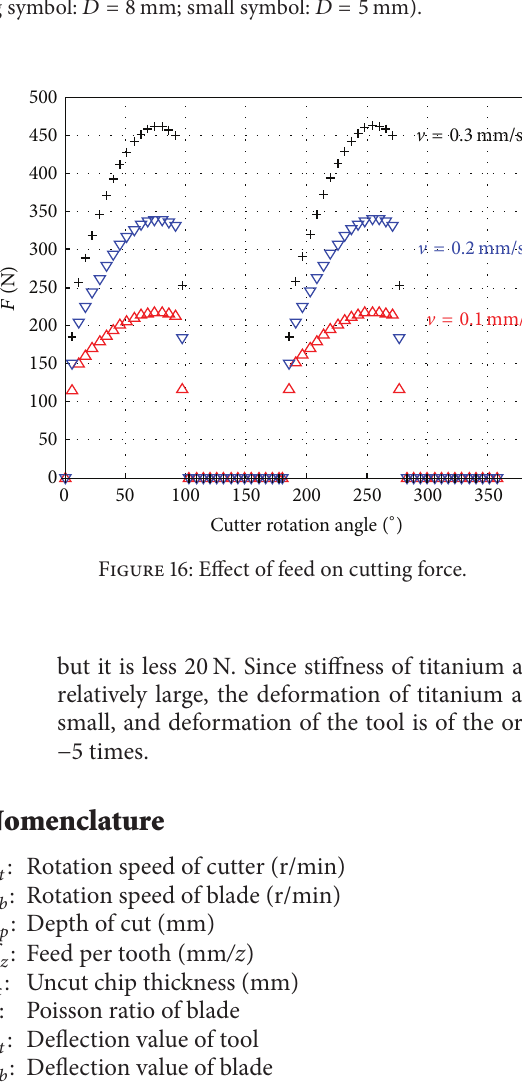
Figure 14: Effect of cutter diameter on cutting force (big symbol: 𝐷 = 8 mm; small symbol: 𝐷 = 5 mm).